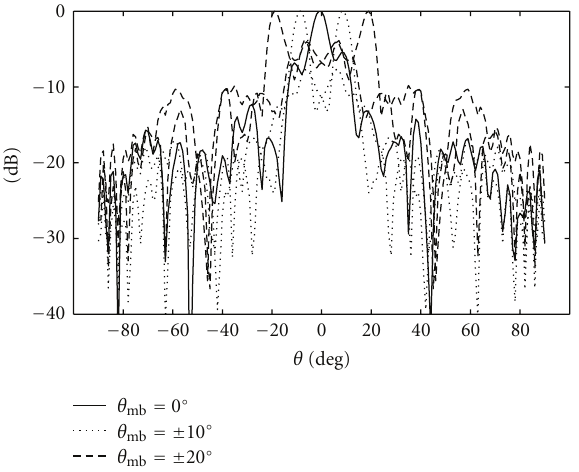
Figure 7: Normalized radiation patterns (copolar components on the x-z plane) measured for di ff erent biasing voltage distributions.